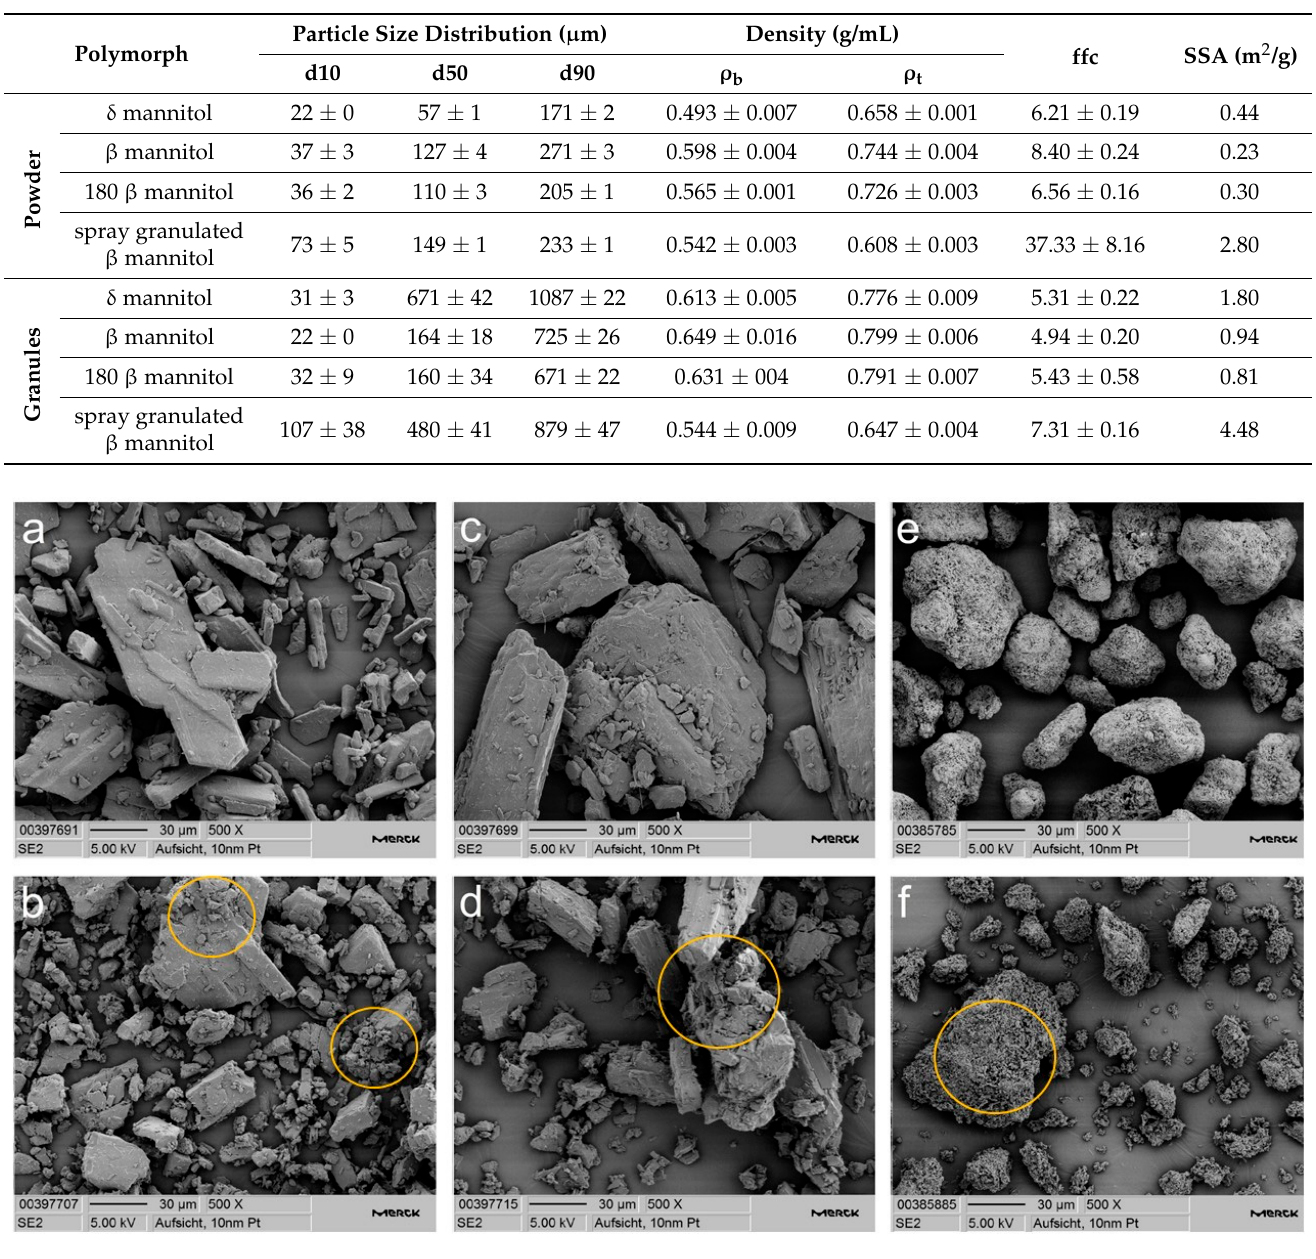
Figure 1. Scanning electron microscopy images of ( a ) δ mannitol powder, ( b ) δ mannitol granules, ( c ) β mannitol powder, ( d ) β mannitol granules, ( e ) spray granulated Parteck M200, and ( f ) spray granulated Parteck M200 after roller compaction at 500× magnification. Regions with high surface roughness after roller compaction marked in yellow.